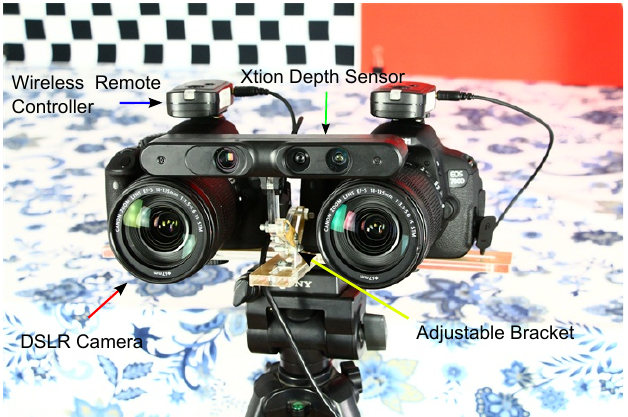
Figure 1. The system used in our method. It consists of two Cannon EOS 700D digital single-lens reflex (DSLR) cameras and one Xtion depth sensor. All DSLR cameras are controlled by the wireless remote controller. We used an adjustable bracket to change the angle and height of the Xtion depth